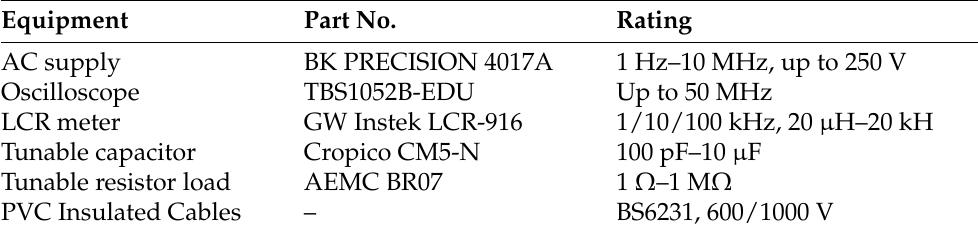
Figure 13. Experimental setup for evaluating the coupling performance of the DD coil prototype. Table 3. List of equipment used for the experimental